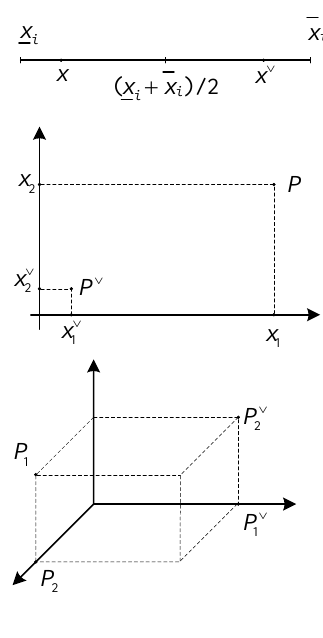
Fig. 3 Illustration of Individuals and the Corresponding